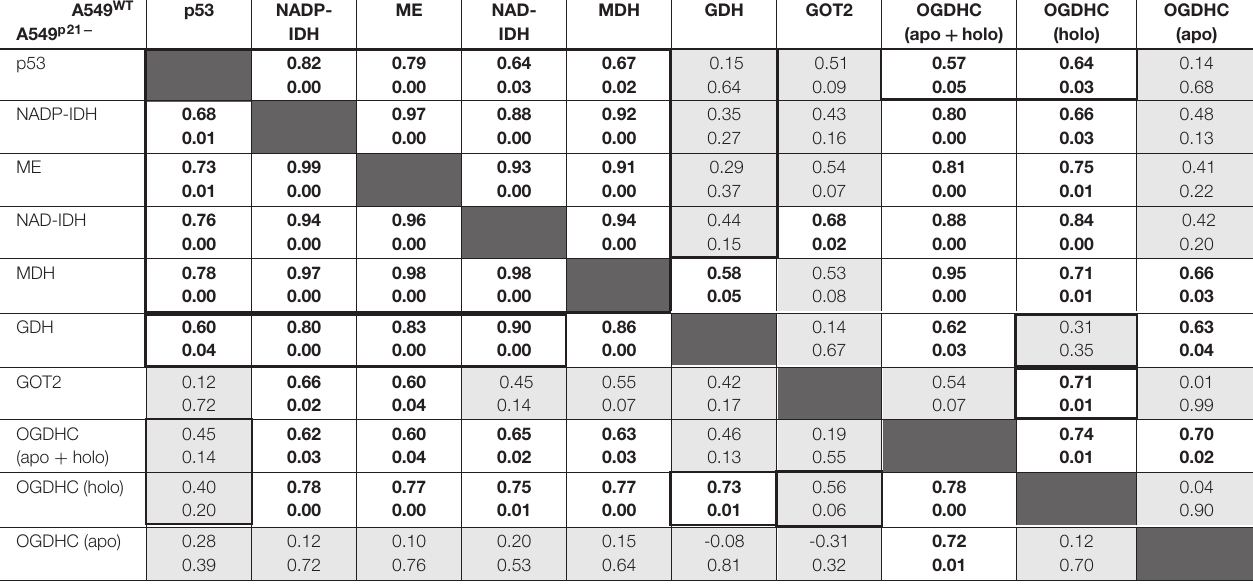
TABLE 1 | Correlations between the levels of p53 and studied enzymes in A549 WT (top right corner) and A549 p21 − (bottom left corner) cell lines at varied thiamine/ThDP levels. A549